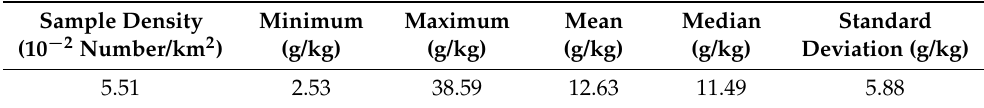
Table 5. Description of statistical characteristics of soil samples. Sample